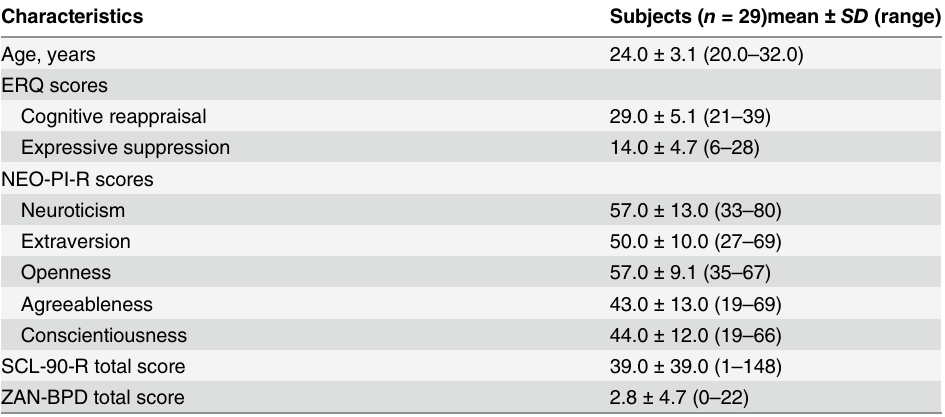
Table 1. Demographic and clinical characteristics of